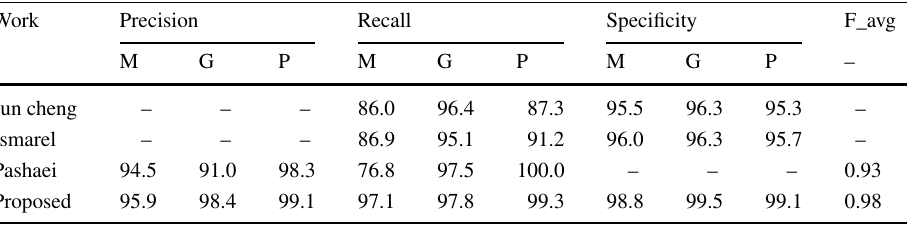
Table 5 Related works and comparison using figshare